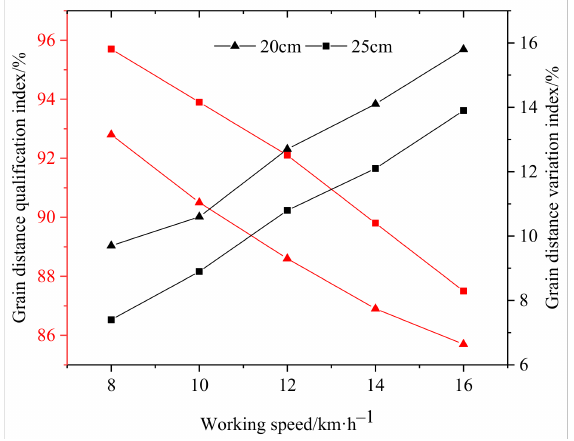
Figure 17. Bench test